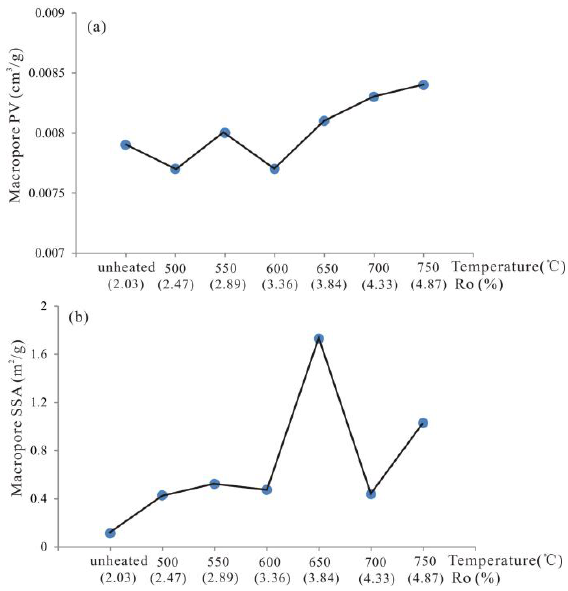
Figure 9. ( a ) Relationships between macropore PV and temperature (%Ro), ( b ) relationships between macropore SSA and temperature